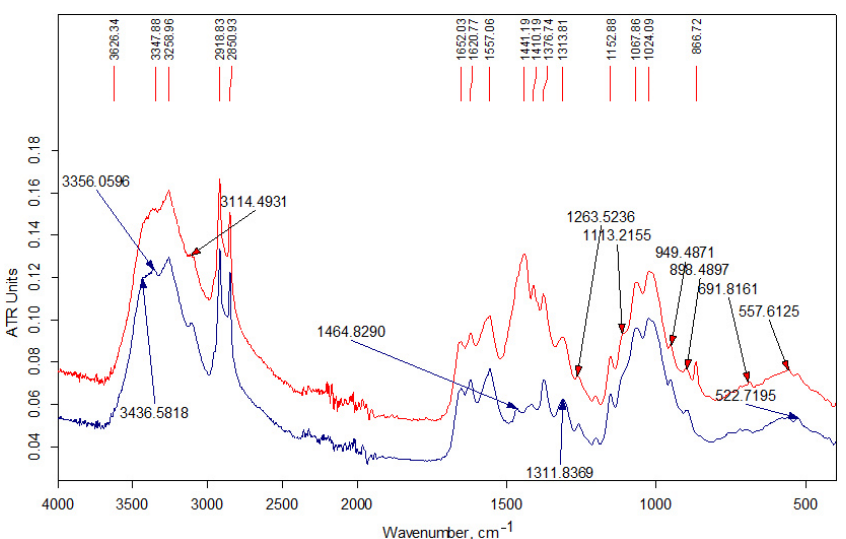
Figure 5. FT-IR spectra of the samples insoluble in acidic aqueous medium: Ch1-L-C16-3ins fraction (bottom); Ch2-L- С22 -10ins fraction (top).